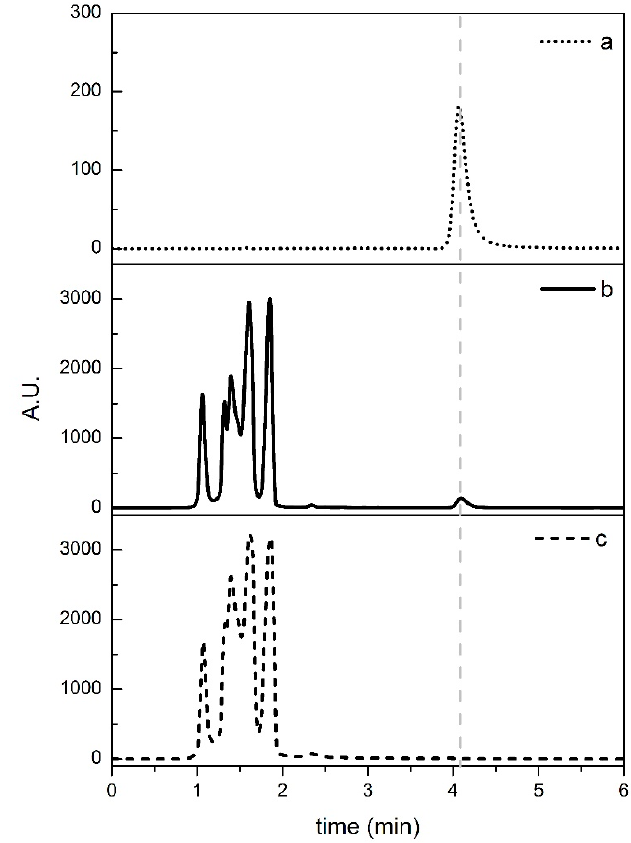
Figure 2. UV-diode array detector (DAD) chromatograms at 210 nm. ( a ) Standard solution of histamine at 40 mg L − 1 ; ( b ) chromatogram of a sample spiked with histamine 200 mg kg − 1 ); ( c ) chromatogram of a blank sample. The grey line at 4.08 min is a visual aid.